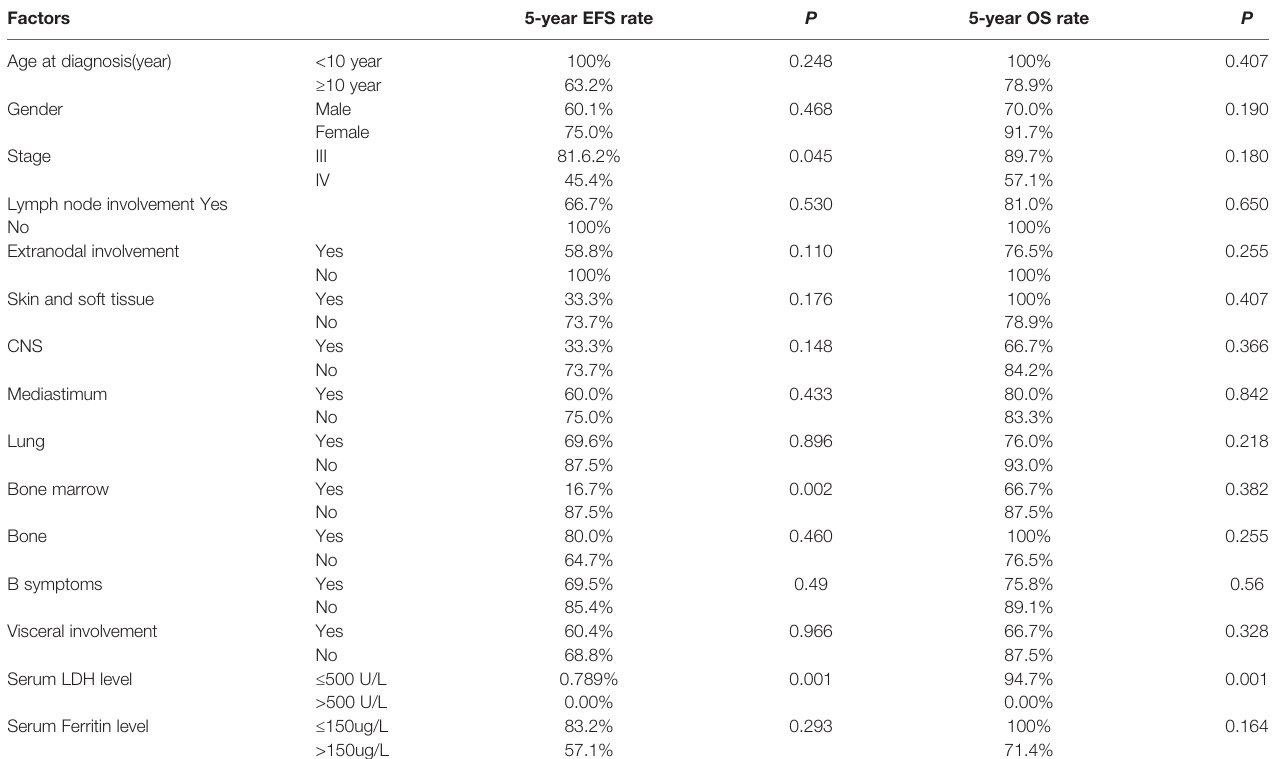
TABLE 3 | Prognostic factors for overall survival and event-free survival rates (log-rank test).